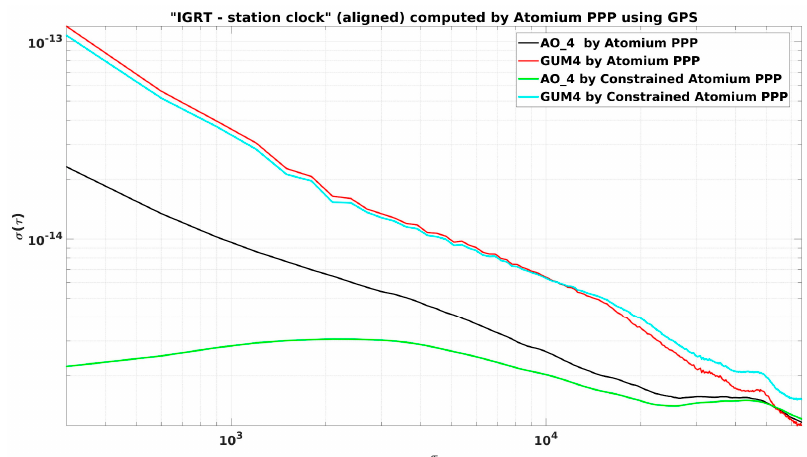
Figure 10. ADEVs in “PPP—OPT” experiments to evaluate constrained PPP. IGRT stands for the reference time of International global navigation satellite systems service (IGS) rapid products that are used in the PPP computation.